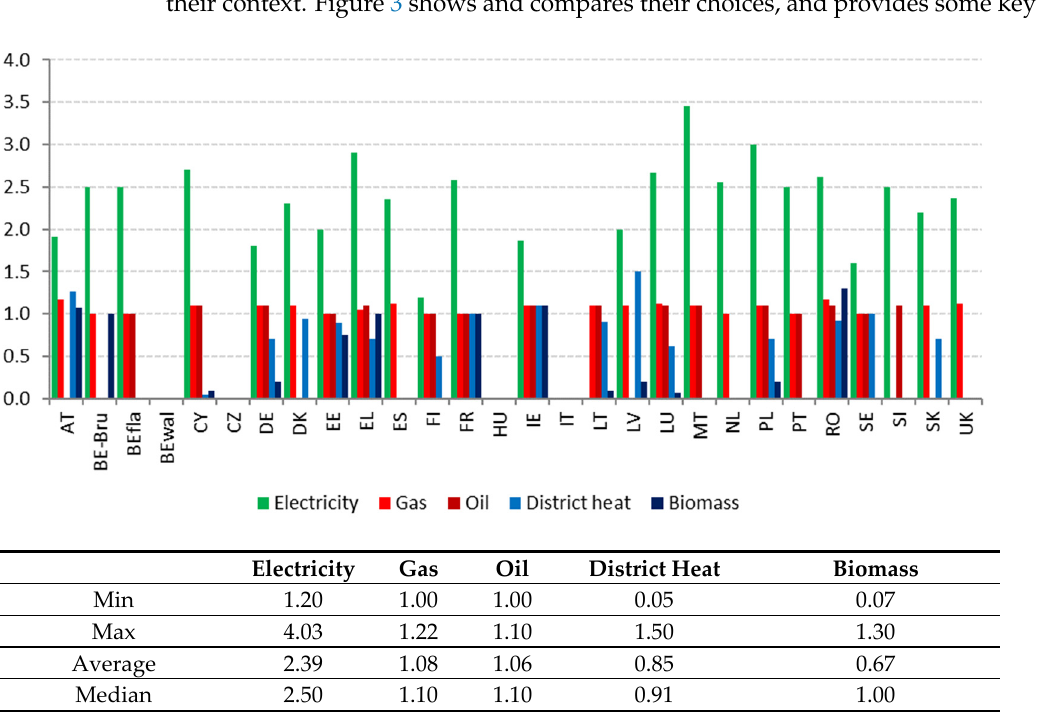
Figure 3. Primary energy factors used by Member States and associated statistics.